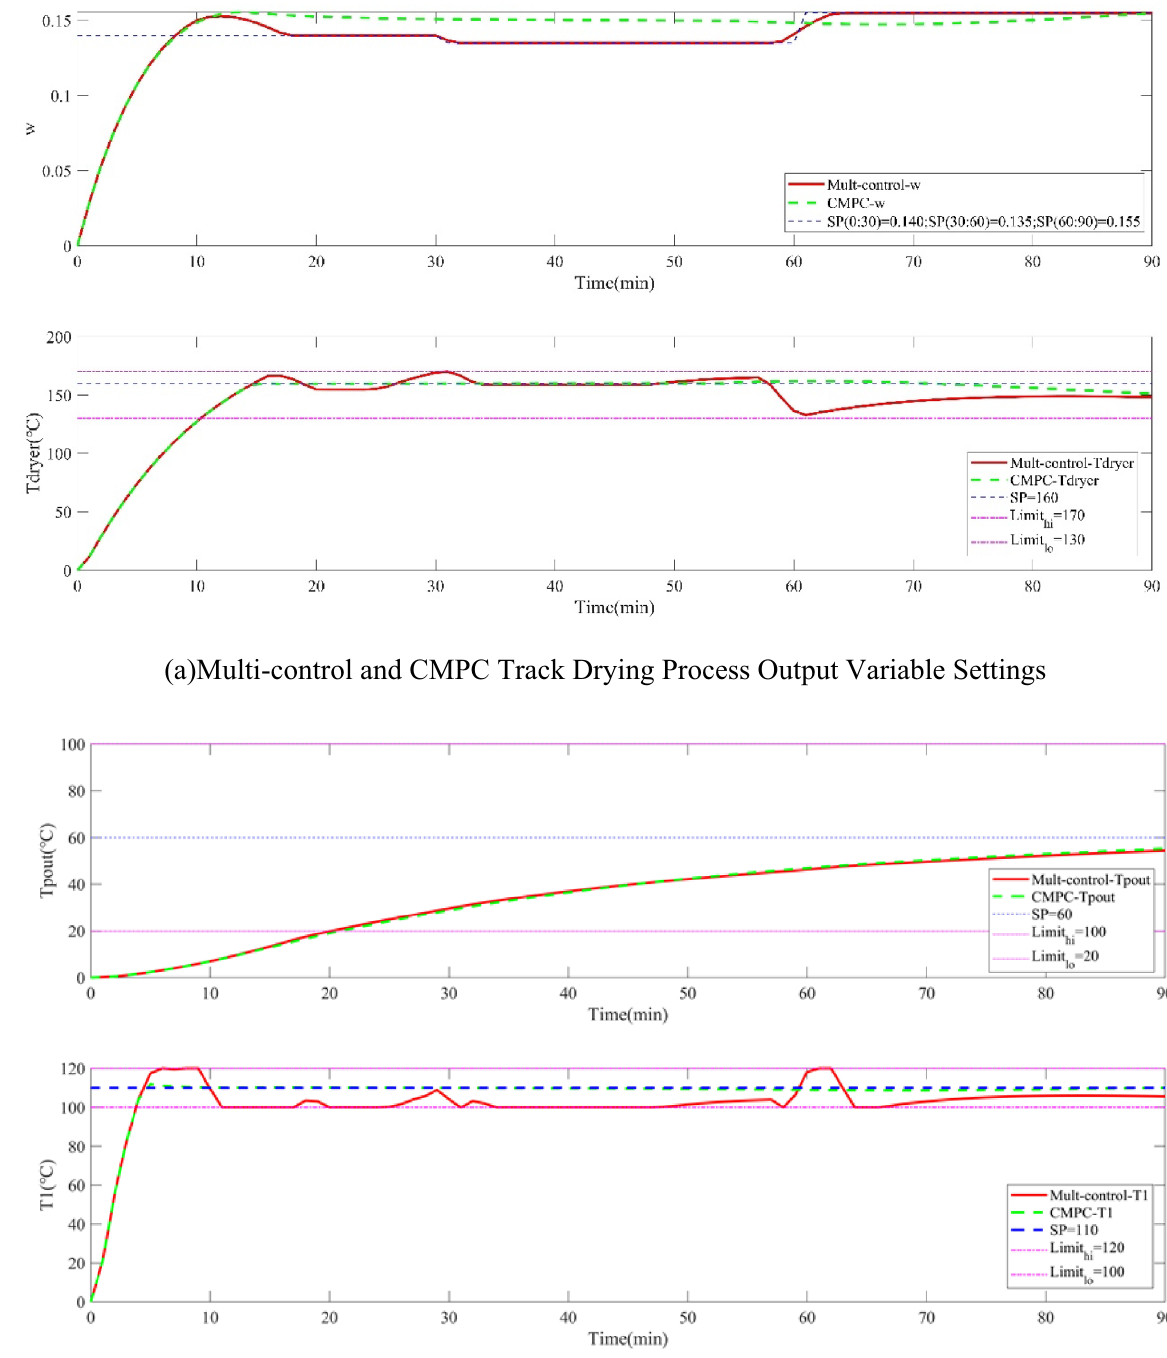
Figure 6. Multi-control and CMPC tracking optimization of tobacco drying process under disturbance